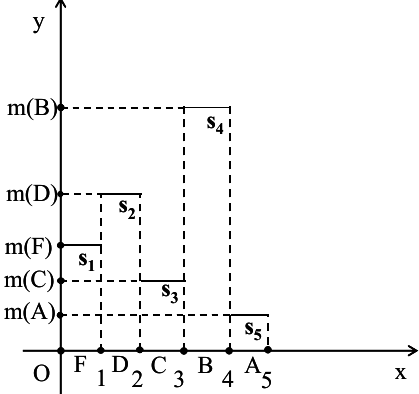
Figure 3. The graph of the membership function.